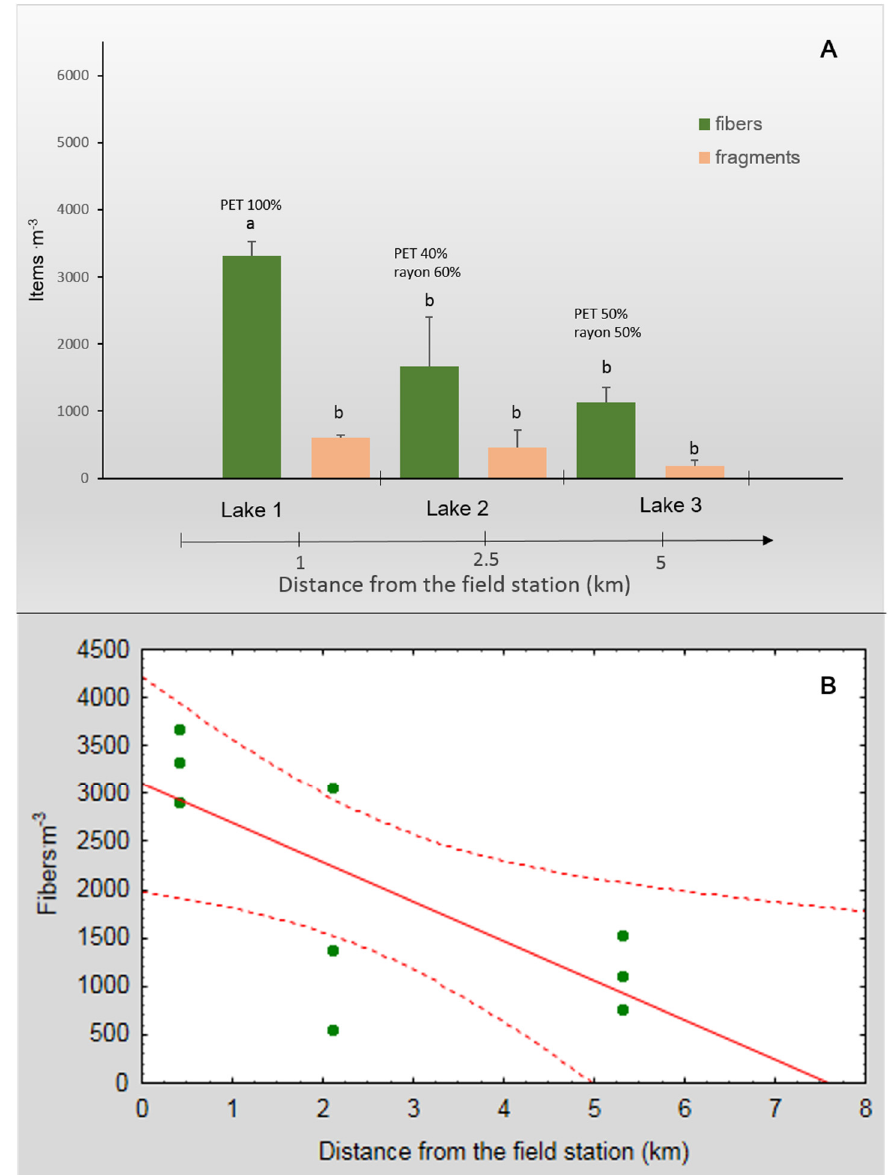
Figure 4. ( A ) The mean number (particles m -3 ) of fibers and fragments found in the surface water of the studied tundra lakes and ( B ) a correlation between the number of fibers and the distance from the field station. The percentages of the different types of fibers are shown: PET and semi-synthetic cellulosic rayon. The bars that share the same letter are not significantly different. Dotted lines represent confidence intervals. The error bars represent ±1SE.